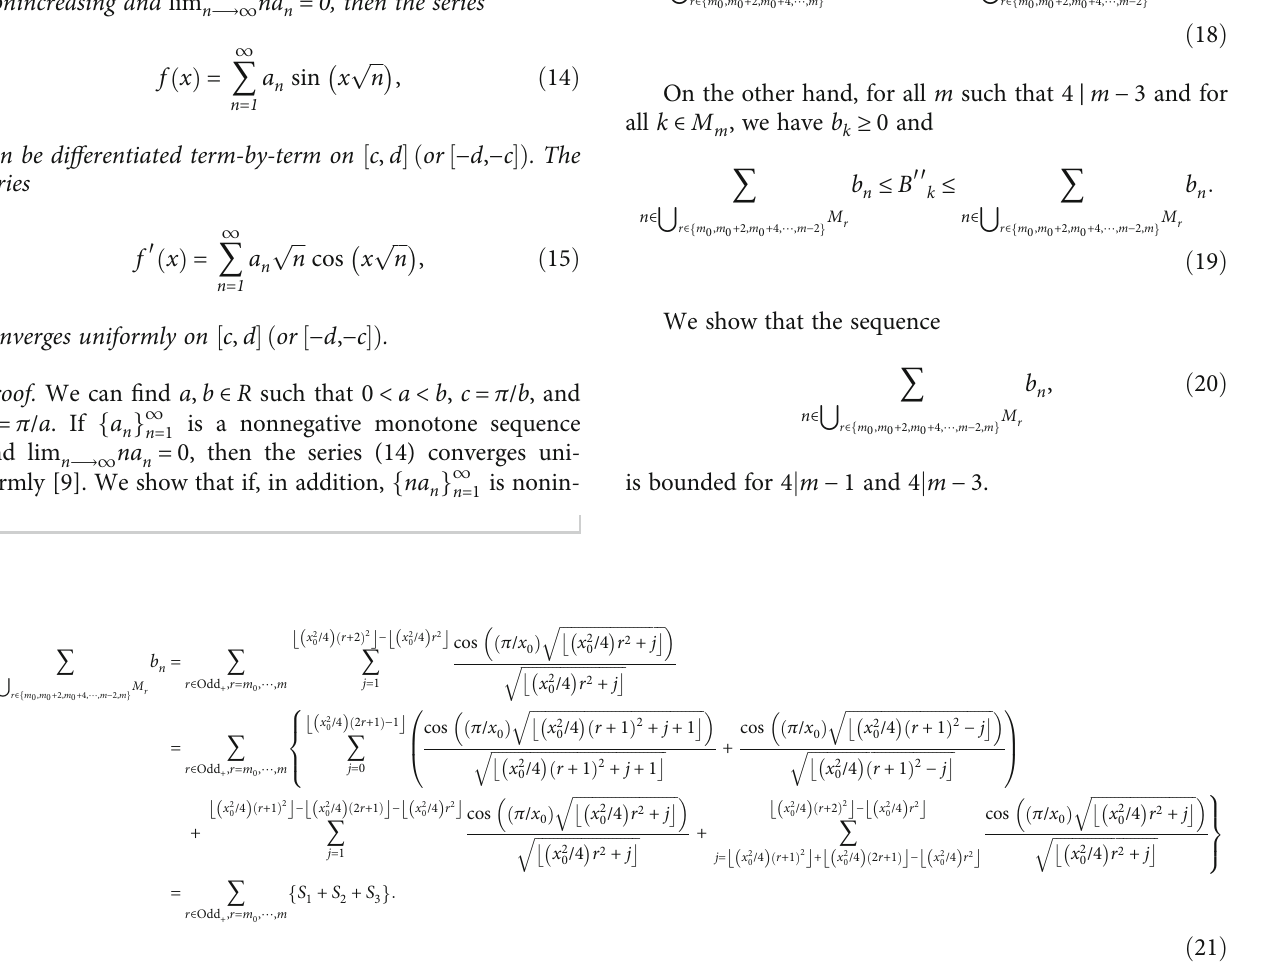
ffiffiffiffiffiffiffiffiffiffiffiffiffiffiffiffiffiffiffiffiffiffiffiffiffiffiffi (cid:3) x 2 /4 0